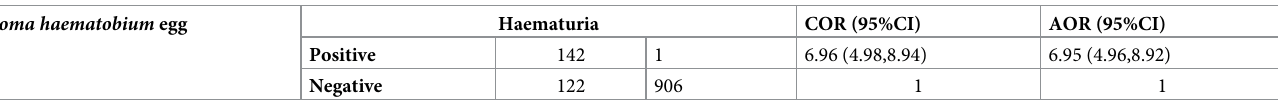
AOR- adjusted odd ratio; CI- confidence interval; COR- crude odd